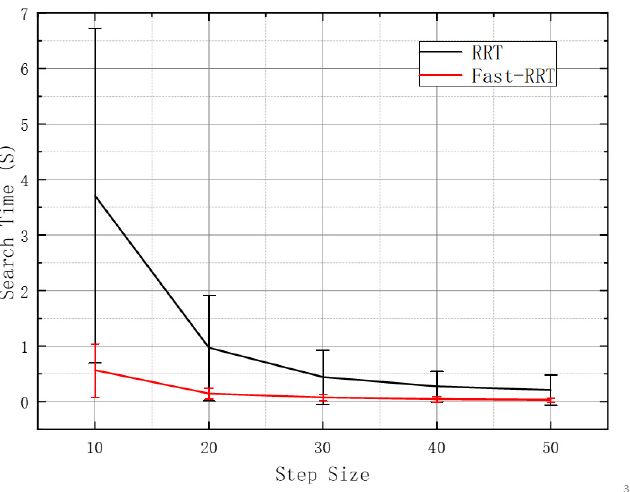
Figure 14. Comparison of the search time between Fast-RRT algorithm and RRT algorithm in the narrow passages as a function of different step sizes.